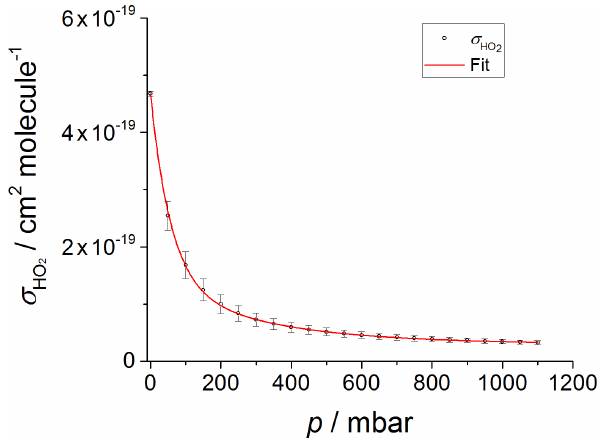
Figure 4. Absorption cross section of HO 2 at 1506.43nm vs. pressure of air. The σ HO values (circles) were computed us- 2 ing the line strengths of the HO 2 transitions contributing to the absorption at 1506.43nm (Thiebaud et al., 2007) and the pressure broadening coefficients were assumed to be the same for all transitions and equal to the average of the values reported for the spectral region between 1499 and 1508nm (0.115cm − 1 atm − 1 = 1.14 × 10 − 4 cm − 1 mbar − 1 ) (Ibrahim et al., 2007) as explained in the main text. The red line is a fit of Eq. (7) to the calculated values. The extracted values of the equation parame- ters are shown in Table S3 in the